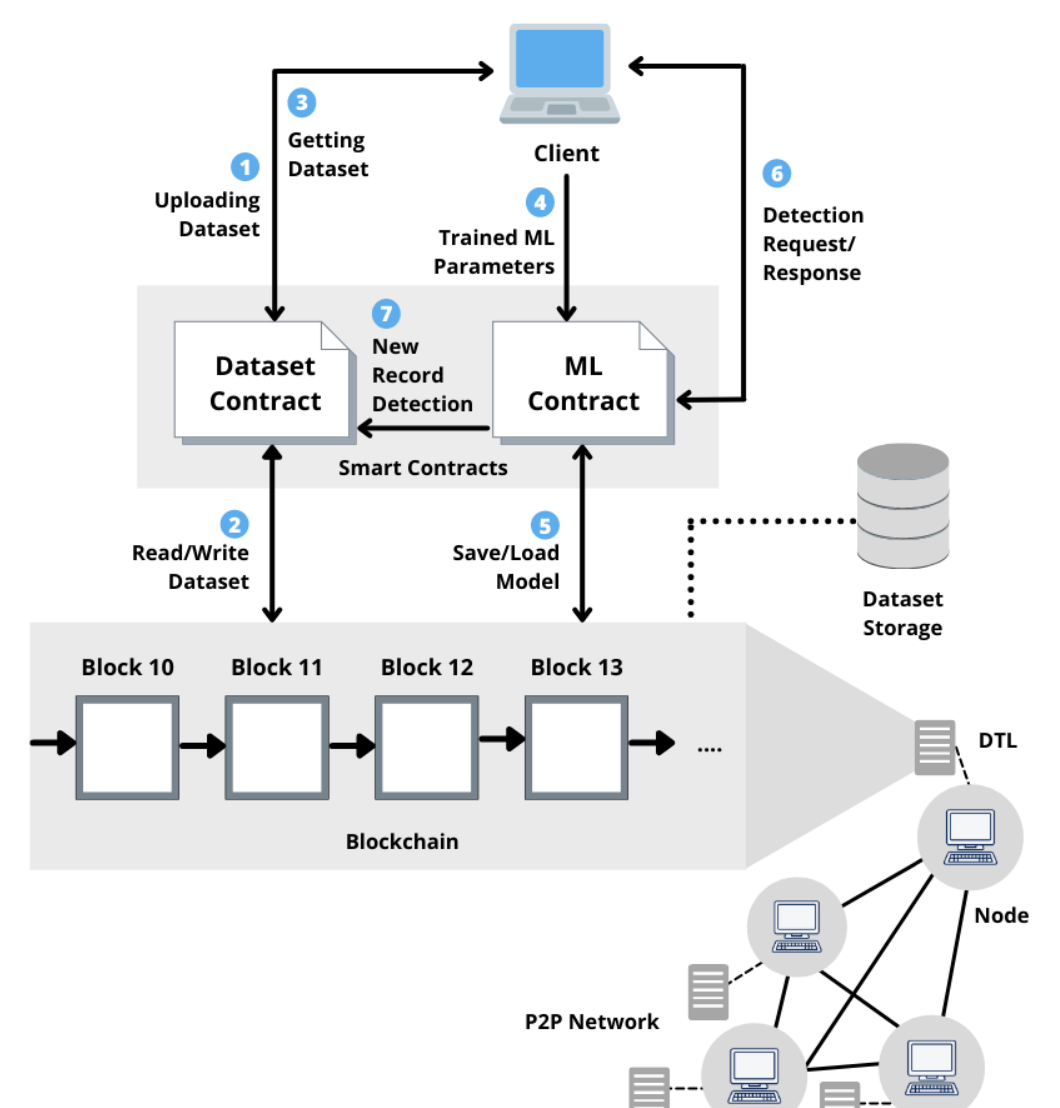
Figure 2. An overview of the proposed model along with entities interaction and